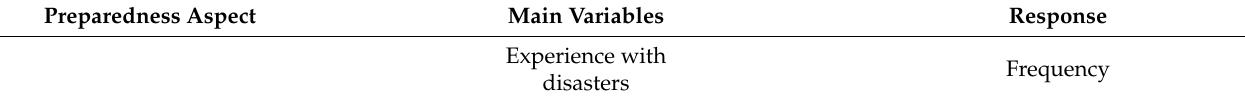
Table 1. Questionnaire structure concerning the preparedness